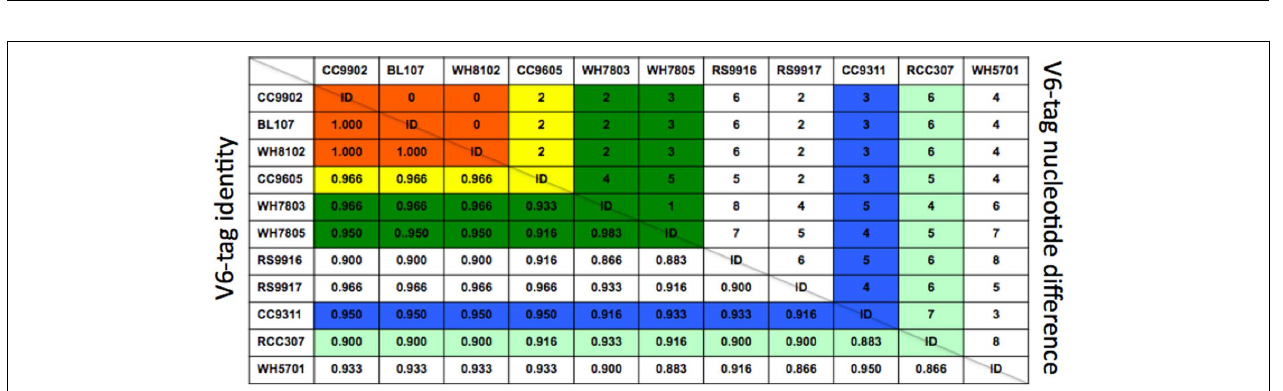
FIGURE 6 | Identity matrix (bottom half) and nucleotide difference of 60 nucleotideV6 hypervariable region of the small subunit (16S) ribosomal rRNA gene in 11 marine/estuarine Synechococcus genomes. Strain CC9902 was taken as the basis for nucleotide identity calculations. ID, identical.